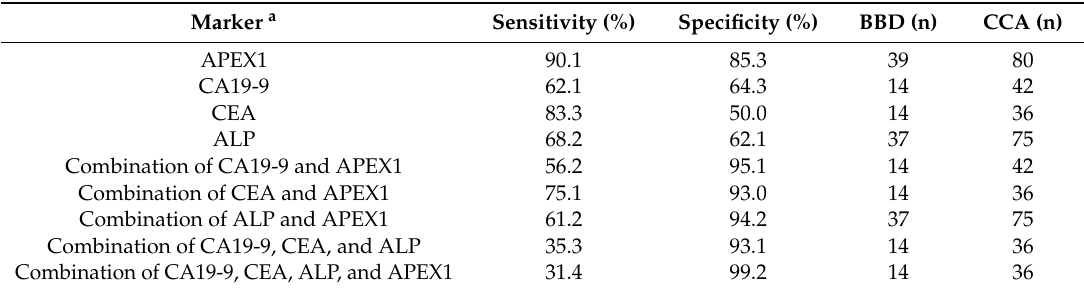
Table 3. The sensitivity and specificity values of currently used serum markers and APEX1 for detecting CCA